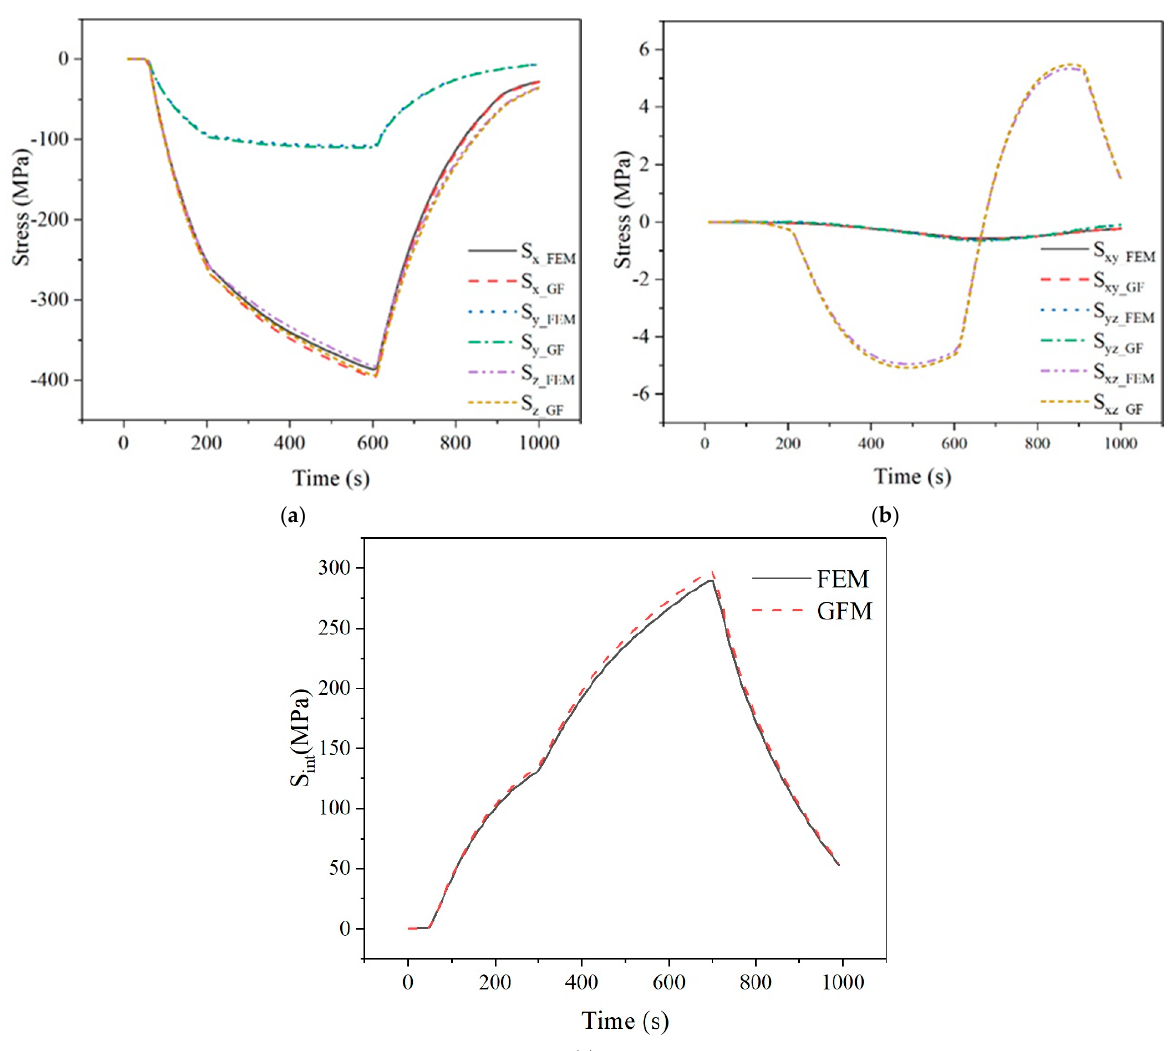
Figure 15. The comparison between Green’s function method(GFM) and Finite element method(FEM). ( a ) Normal stress. ( b ) Shear stress. ( c ) Stress intensity.